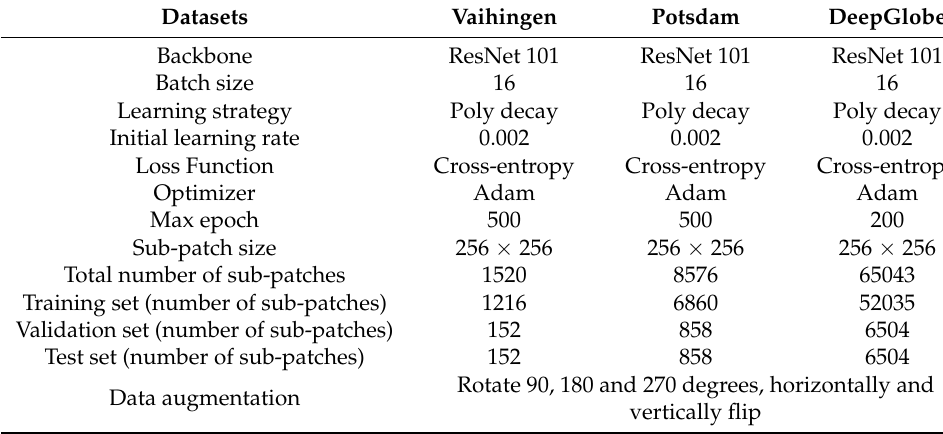
Table 2. Hyper-parameters and implementation details.